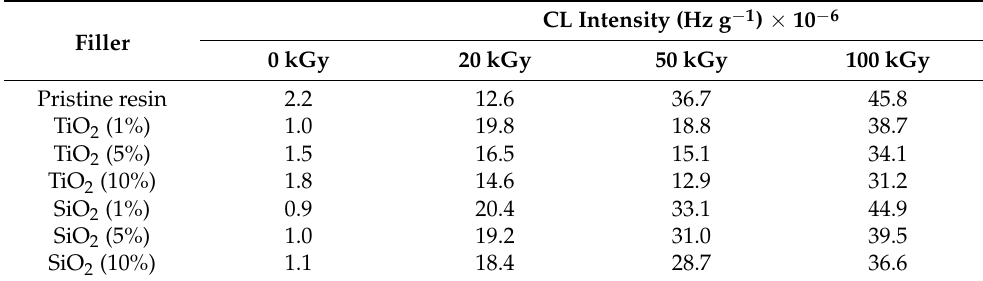
Table 6. CL intensities measured on γ -irradiated epoxy nanocomposites [150]. Filler Pristine resin